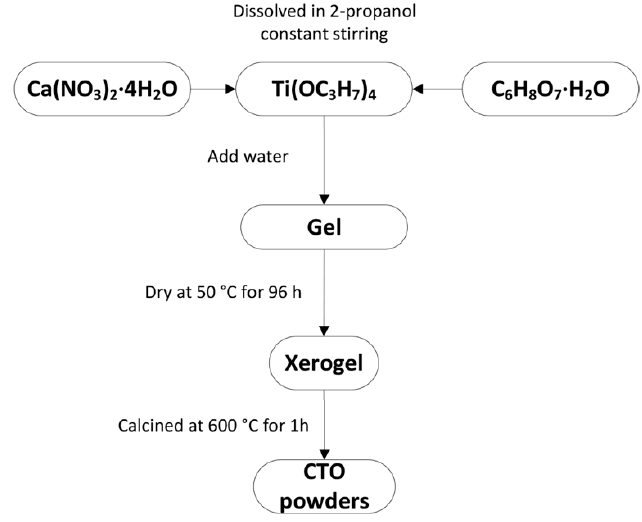
Figure 1. Flowchart for CaTiO 3 nanoparticles (CTO) preparation procedure.